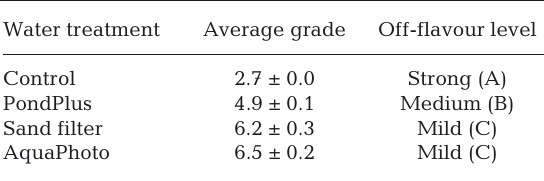
Table 5. Off-flavour profiling of tilapia from ponds with dif- ferent treatment. Numeric scores of grades (see Table 1) are mean ± SE; n = 48 (12 from each pond treatment). The grad- ing was statistically different for each water treatment type (p < 0.05; ANOVA) except between the sand filter and AquaPhoto